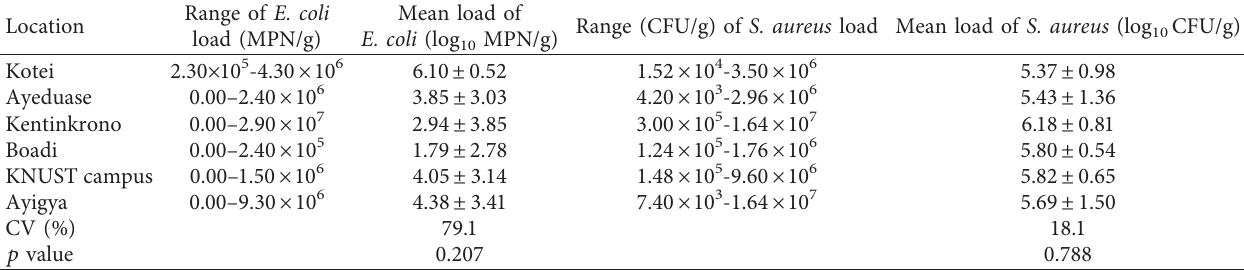
Table 3: Mean load of E. coli and S. aureus in gizzard khebab sold on the KNUST campus and its environs. Location